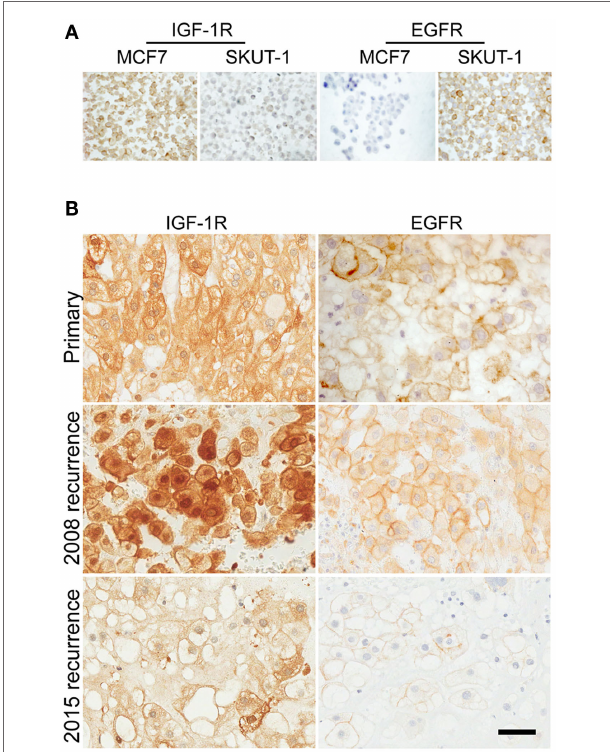
FIGURe 3 | Chordoma of trial patient contains prominent nuclear IGF-1R and membrane eGFR . (a) The specificity of IGF-1R and EGFR IHC was tested using sections of formalin-fixed, paraffin-embedded MCF7 breast cancer cells (high IGF-1R, low EGFR) and SKUT-1 leiomyosarcoma cells (IGF-1R deficient, EGFR positive). (B) Sections of chordoma from the trial patient were stained for IGF-1R and EGFR, including primary tumor from 2003, and recurrent tumor from 2008 (pre-trial) and 2015 (post-trial). Scale bar: 50 μ m.